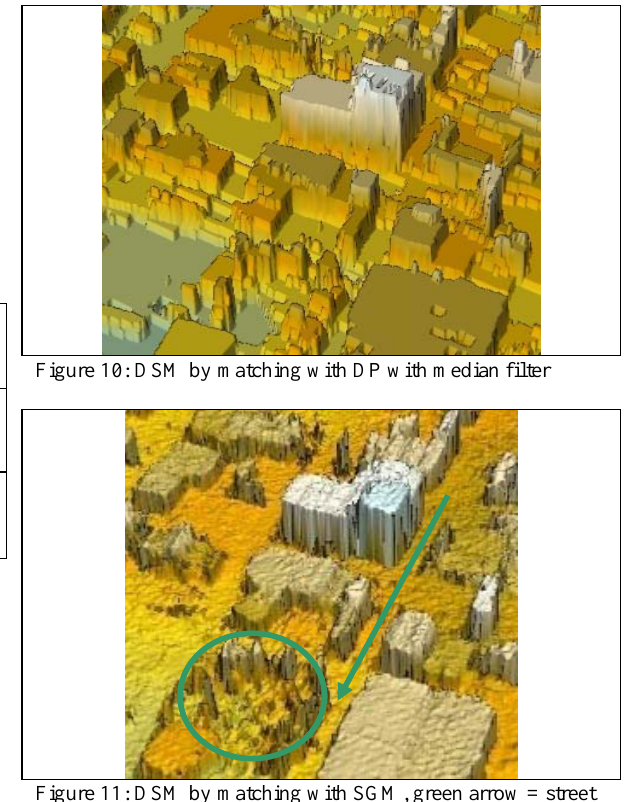
Figure 11: DSM by matching with SGM, green arrow =